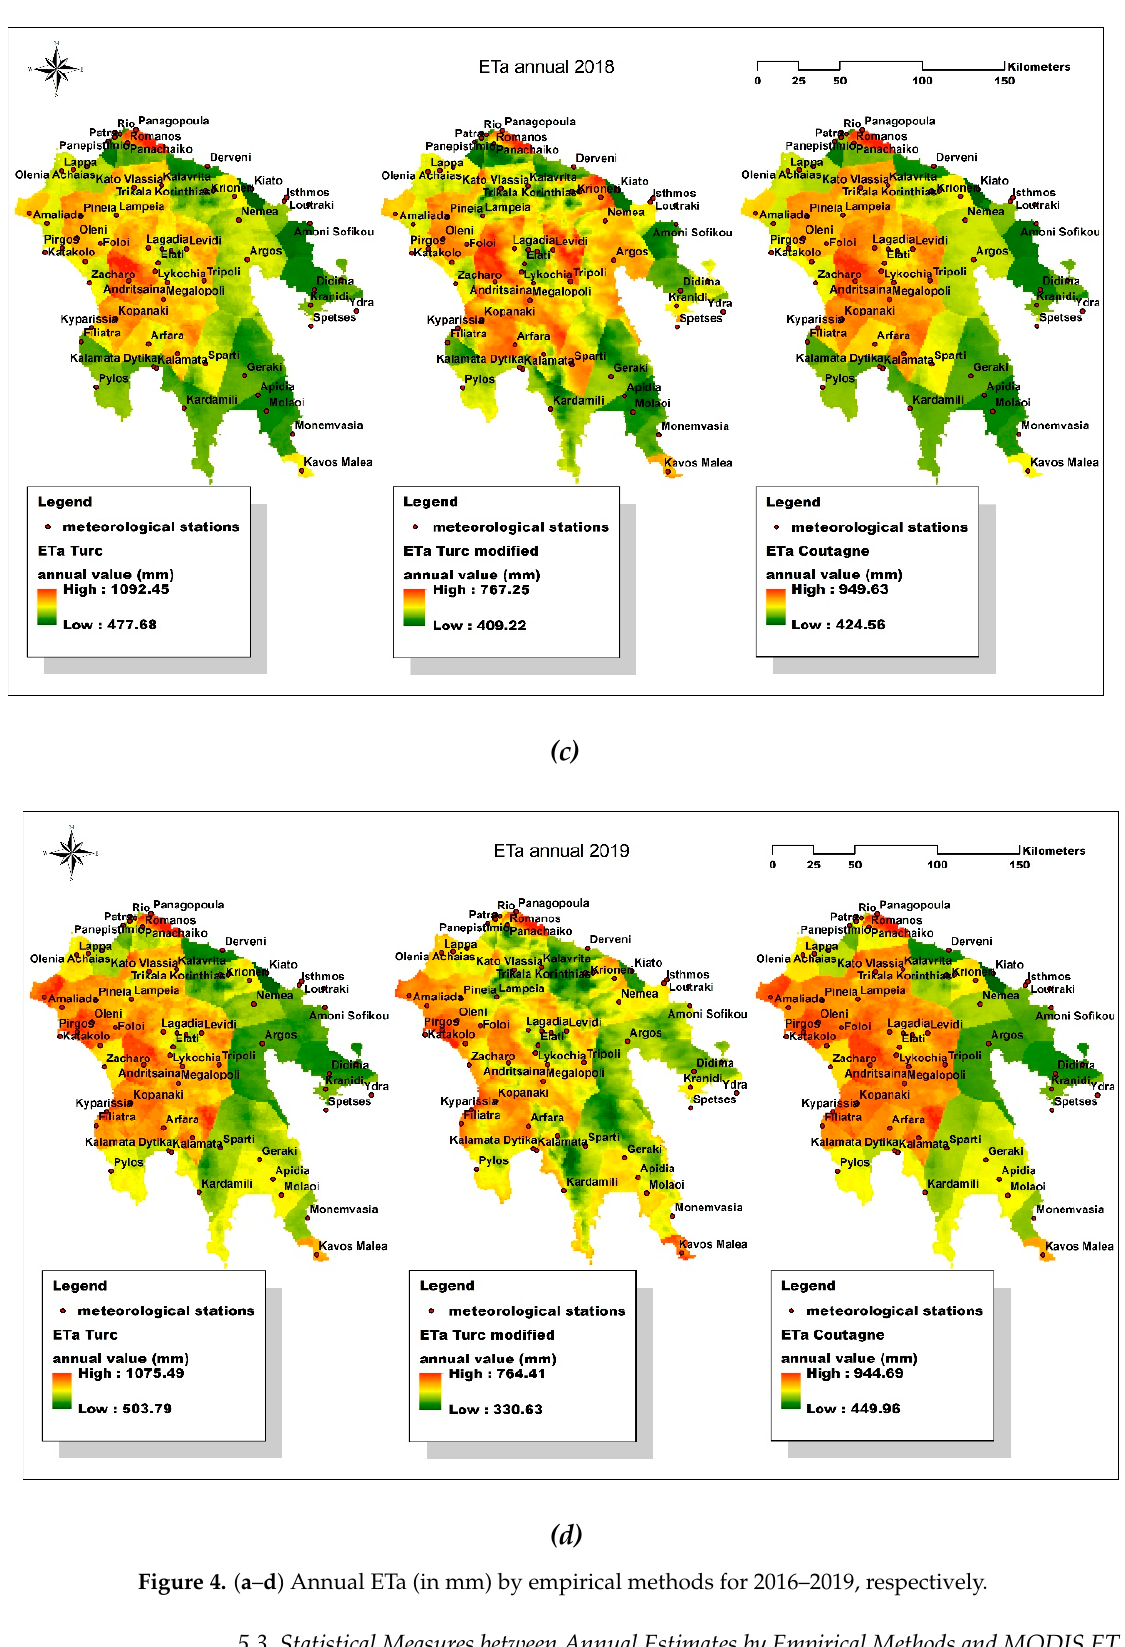
Statistical indices between empirical methods for the annual ETa and MODIS ET estimates (the latter derived via the sum of MOD16A2V6 8-day composites,